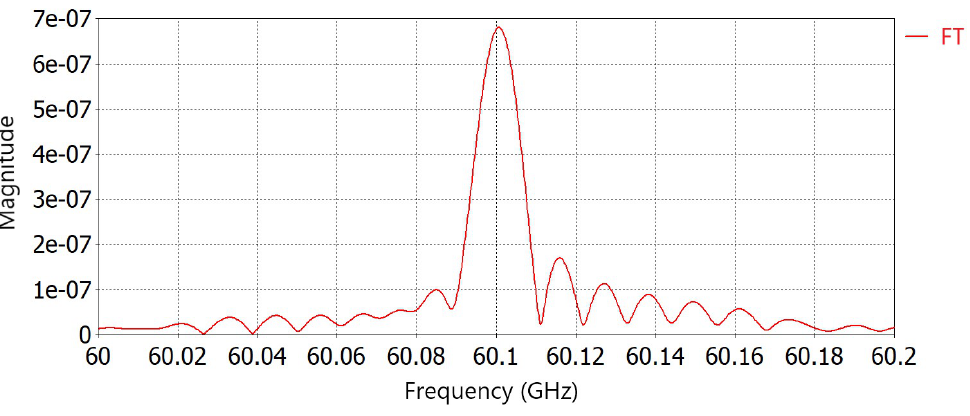
Figure 8. Spectrum of output